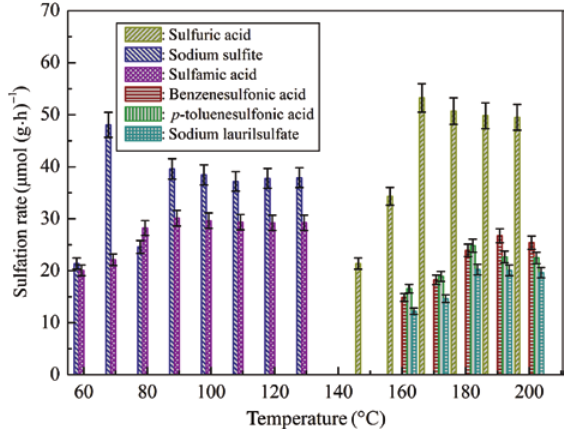
Figure 3: Sulfation rates of SVR with six sulfo and sulfoalkyl chemi- cals at different temperatures. Initial reaction rates were obtained from the sulfate production amounts at a wet curing period of about 1.0 h.